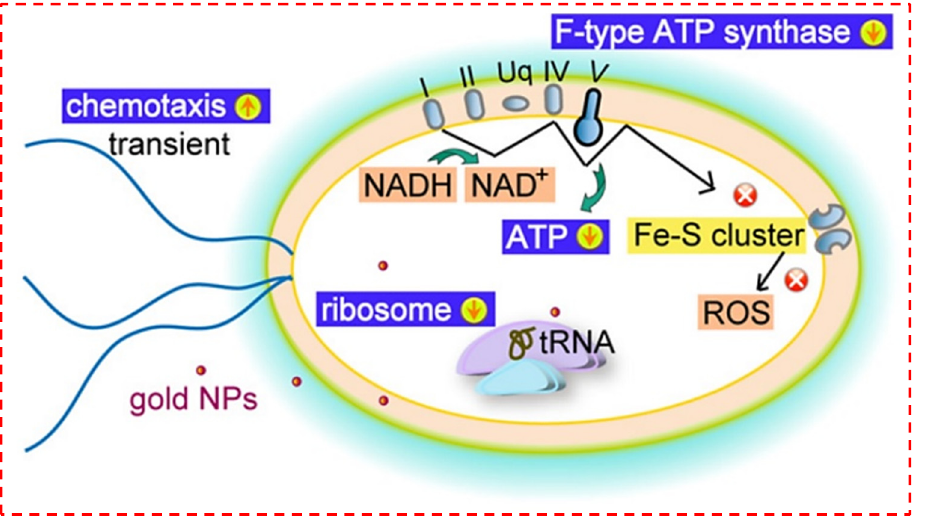
Figure 4. The schematic presentation of feasible antibacterial mechanisms of Au nanoparticles (AuNPs) [47]. (AuNPs)